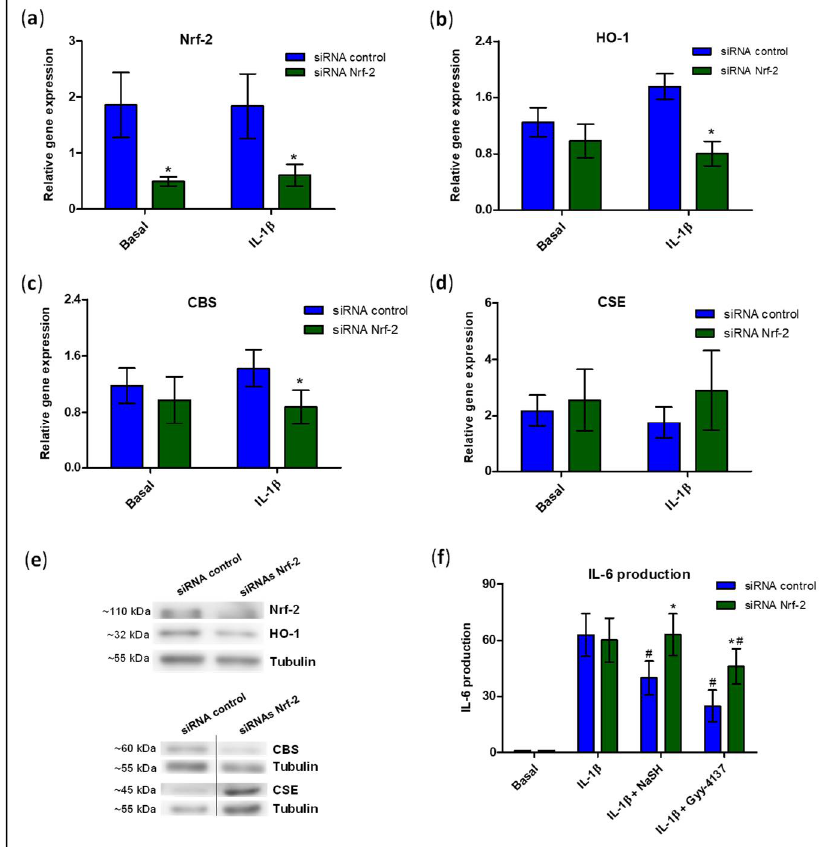
Figure 6. siRNA-induced reduction in Nrf-2 expression modulates HO-1 and CBS levels and attenuates anti-inflammatory effects of exogenous administration of H 2 S on IL-1β-stimulated chondrocytes under a HG environment. TC28a2 cells were transfected with the control or NRF-2 siRNA and then incubated in growth media with high levels of glucose in the presence or absence of IL-1β. Then, the gene expression of ( a ) Nrf-2, ( b ) HO-1, ( c ) CBS, and ( d ) CSE were analysed. ( e ) Representative images of one experiment evaluating protein expression of Nrf-2, HO-1, CBS, and CSE by western blot. Protein levels of tubulin were used as the loading control. ( f ) IL-6 production was analysed by ELISA. Basal condition in cells transfected with siRNA = 1. Values are mean ± SEM. * p ≤ 0.05 vs. respective condition in cells transfected with siRNA control, analysed by the Wilcoxon test. # p ≤ 0.05 vs. cells treated with IL-1β alone (n = 3). CBS, cystathionine β-synthase; CSE, cystathionine γ-lyase; HO-1, hemeoxygenase-1; IL-6, interleukin 6; Nrf-2, nuclear factor erythroid 2-related factor 2.